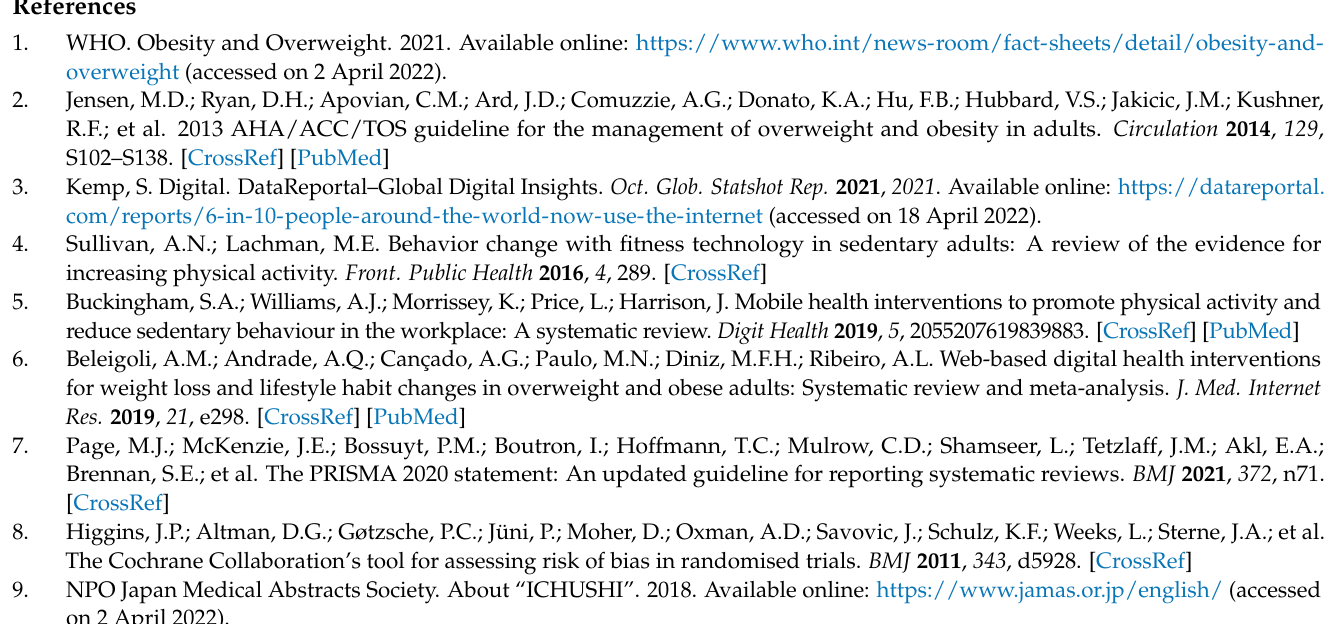
Table S2. The search terms and formulas for Ichu-shi Web; Table S3. The specific features of the retrieved studies; Table S4. The quality of the evidence of 97 articles; Table S5. The categorized components of 97 articles; Table S6. The characteristics of the interventions retrieved in the meta- analysis; Figure S1. Meta-analysis for mean weight change comparing web-based interventions with offline control groups through computers; Figure S2. Meta-analysis for mean weight change comparing web-based interventions with offline control groups through smartphone apps; Figure S3. Meta-analysis for mean weight change comparing web-based interventions with offline control groups from papers published from 2001 to 2010; Figure S4. Meta-analysis for mean weight change comparing web-based interventions with offline control groups from papers published from 2011 to 2015; Figure S5. Meta-analysis for mean weight change comparing web-based interventions with offline control groups from papers published from 2016 to 2020; Figure S6. Meta-analysis for mean weight change comparing web-based interventions with offline control groups for <3 months of duration; Figure S7. Meta-analysis for mean weight change comparing web-based interventions with offline control groups for 3–6 months of duration; Figure S8. Meta-analysis for mean weight change comparing web-based interventions with offline control groups for >6 months of